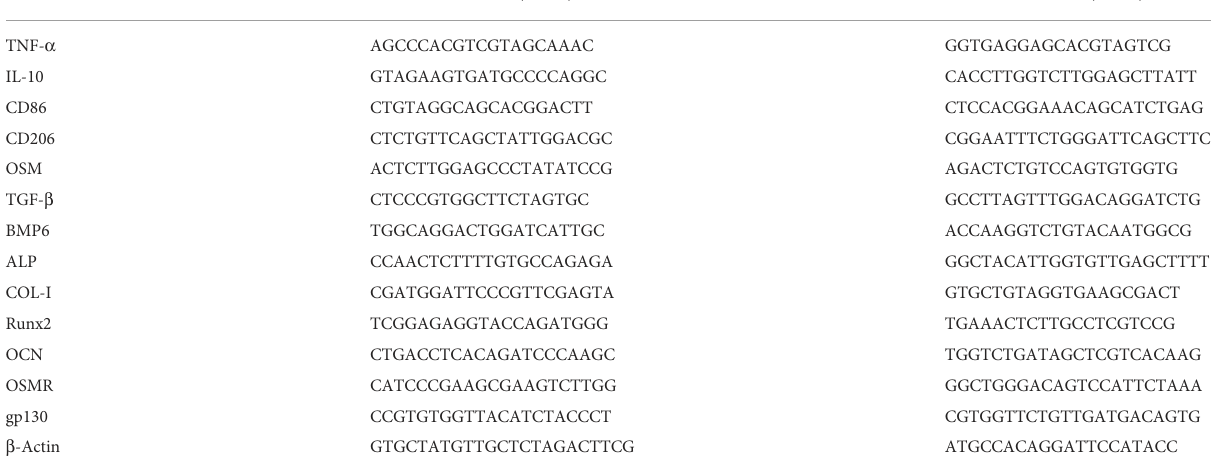
TABLE 1 Primers used in